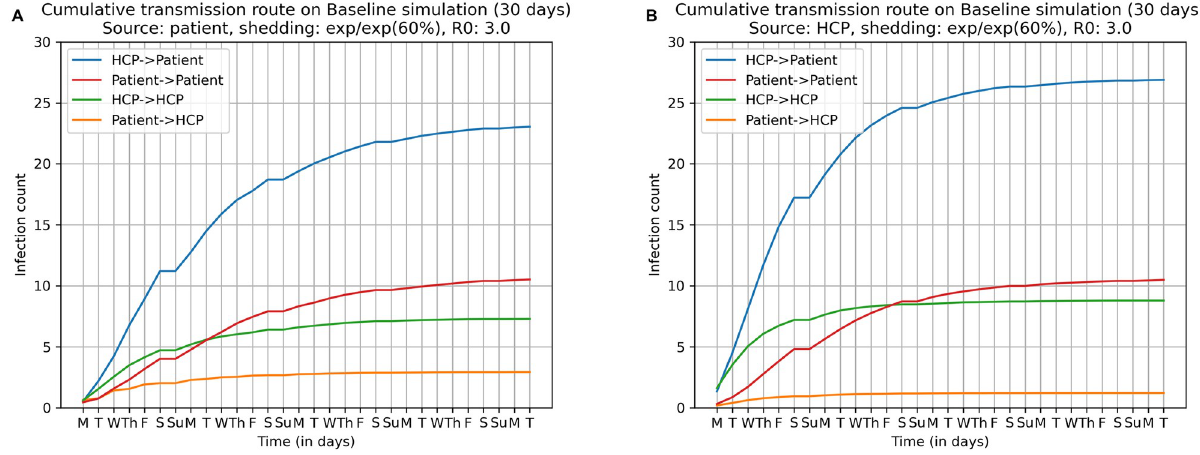
Fig 4. Cumulative distributions of transmission events over 30 days in Baseline simulation. (A) Scenario 1: dialysis patient is the infection source and (B) Scenario 2: HCP is the infection source . In both scenarios, the most frequent transmission route is from HCP ! patient (52.7% in Scenario 1 and 56.8% in Scenario 2), followed by patient ! patient (22.1% in Scenario 1 and 22.5% in Scenario 2), HCP ! HCP (16.6% in Scenario 1 and 18.5% in Scenario 2), and a small fraction of patient ! HCP transmission (6.7% in Scenario 1 and 2.6% in Scenario